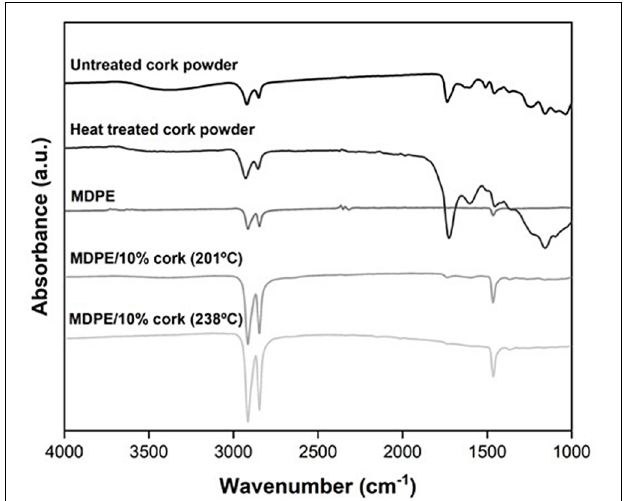
FIGURE 6 | FTIR spectrum for untreated cork powder, heat-treated cork powder for 48 h in the oven at 255 ◦ C, virgin MDPE and MDPE/10% cork part processed at 238 ◦